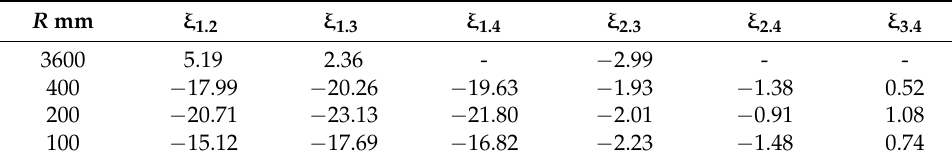
Table 3. Deviation calculation between bending moments in Table 2 (unit: %). R mm ξ 1.2 ξ 1.3 ξ